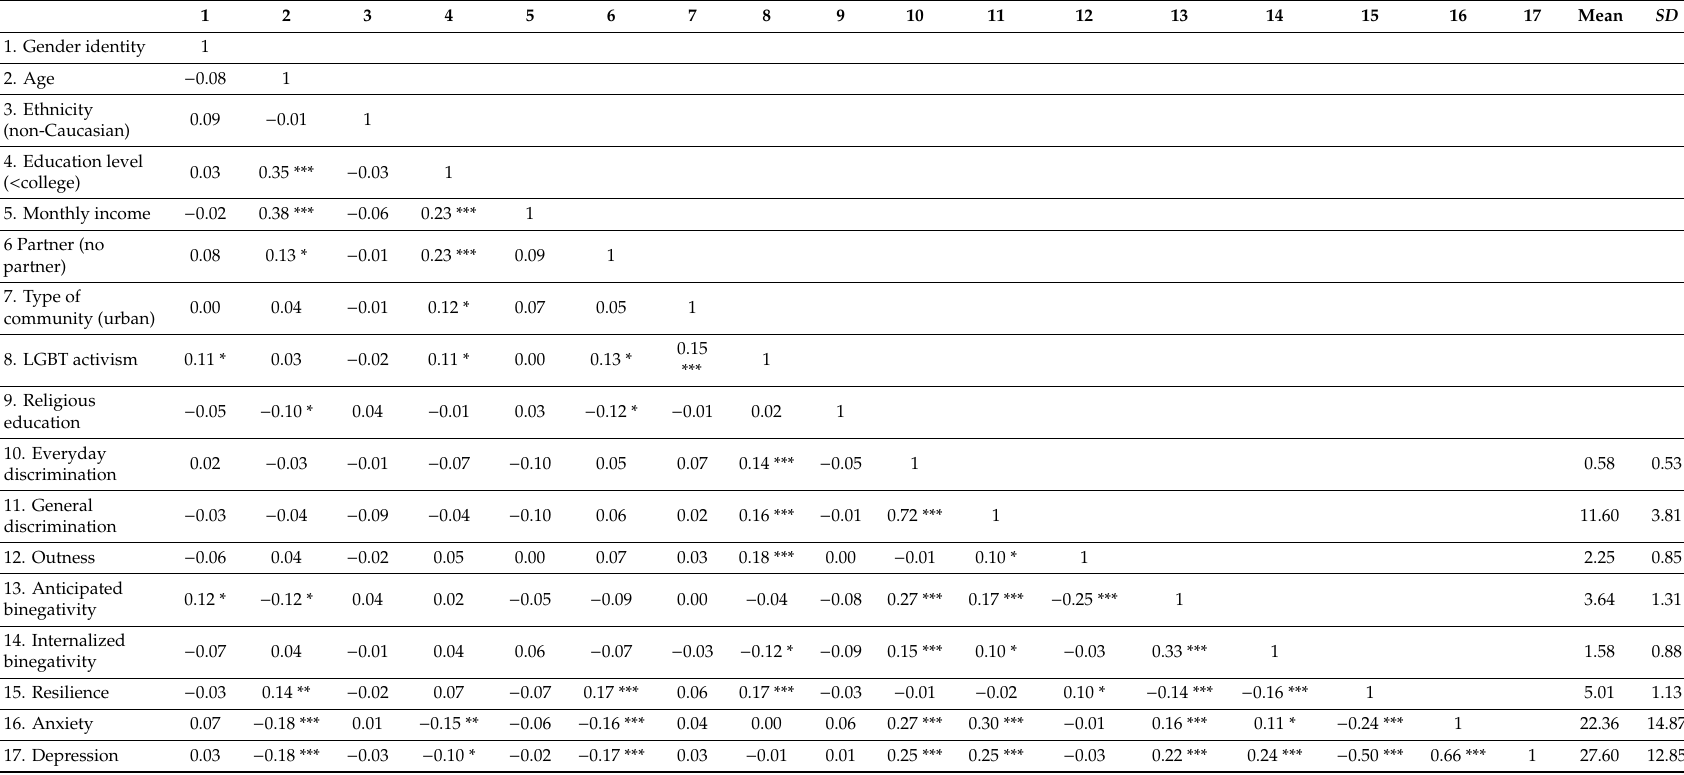
Table 2. Descriptive statistics and bivariate correlations among socio-demographic factors, minority stressors, resilience, and psychological